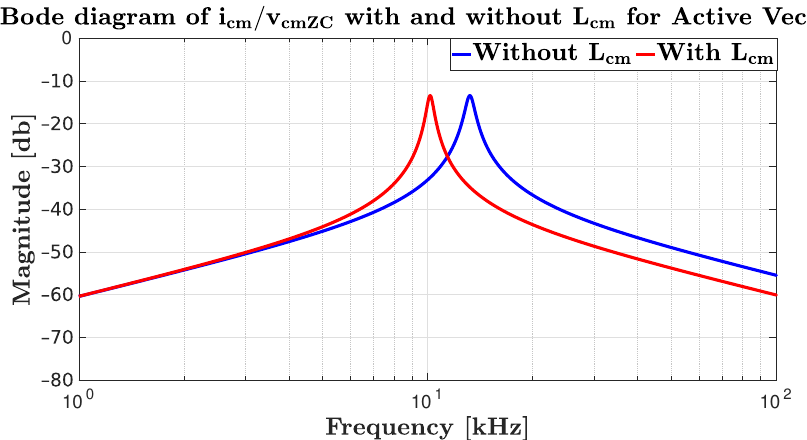
Figure 21. Bode Diagram of i cm ( s ) / v cmZC ( s ) with and without L cm = 3 × 2mH during Active Vectors application.